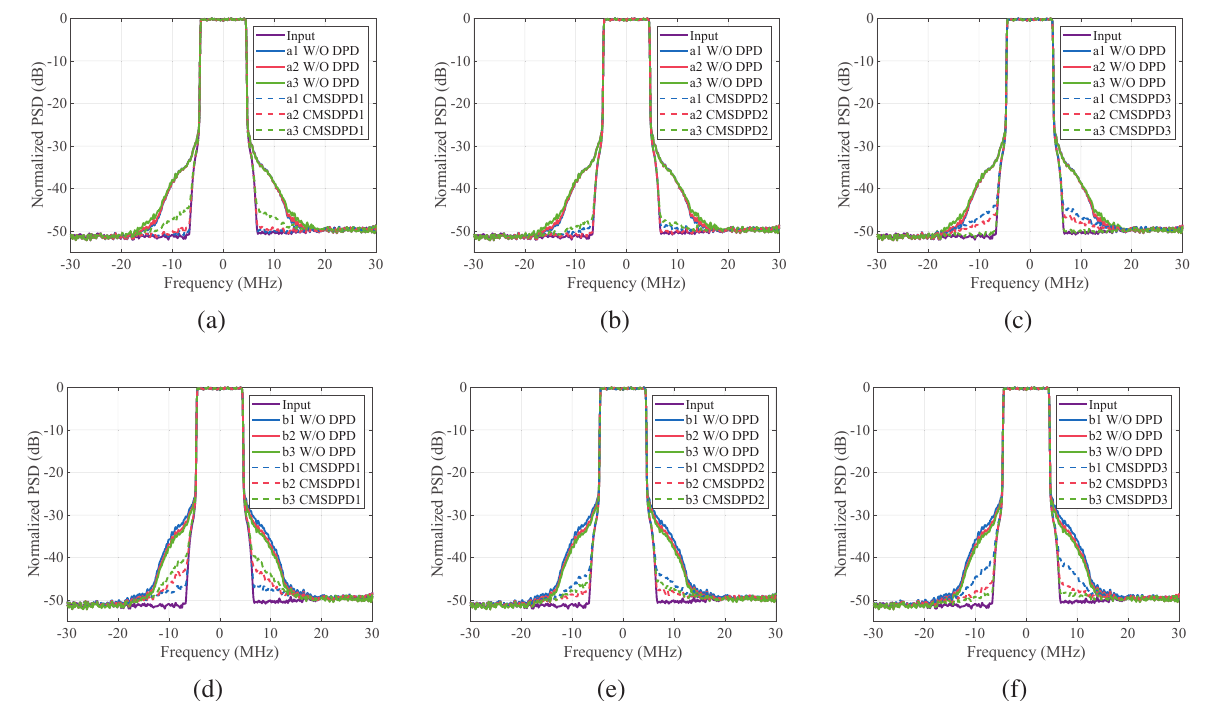
Figure 9. Simulation results of PSDs with and without CMUDPD. ( a ) Modes a1, a2, and a3 with and without CMUDPD1. ( b ) Modes a1, a2, and a3 with and without CMUDPD2. ( c ) Modes a1, a2, and a3 with and without CMUDPD3. ( d ) Modes b1, b2, and b3 with and without CMUDPD1. ( e ) Modes b1, b2, and b3 with and without CMUDPD2. ( f ) Modes b1, b2, and b3 with and without